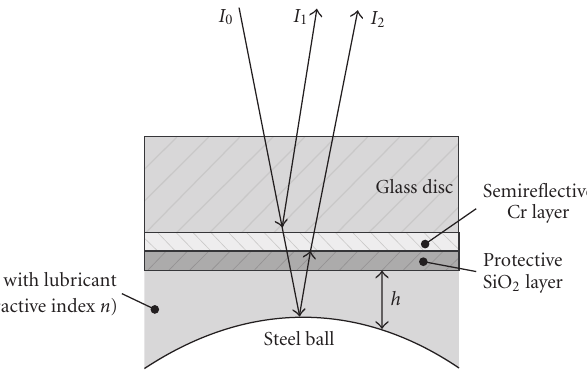
Figure 1: Basic principle of interferometric film thickness